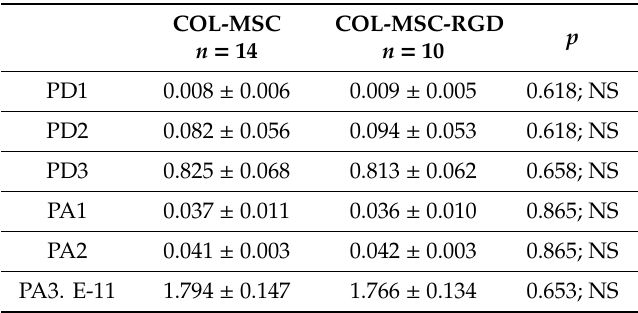
Table 2. Probabilities of the 6 steps of the NMMIIA CB